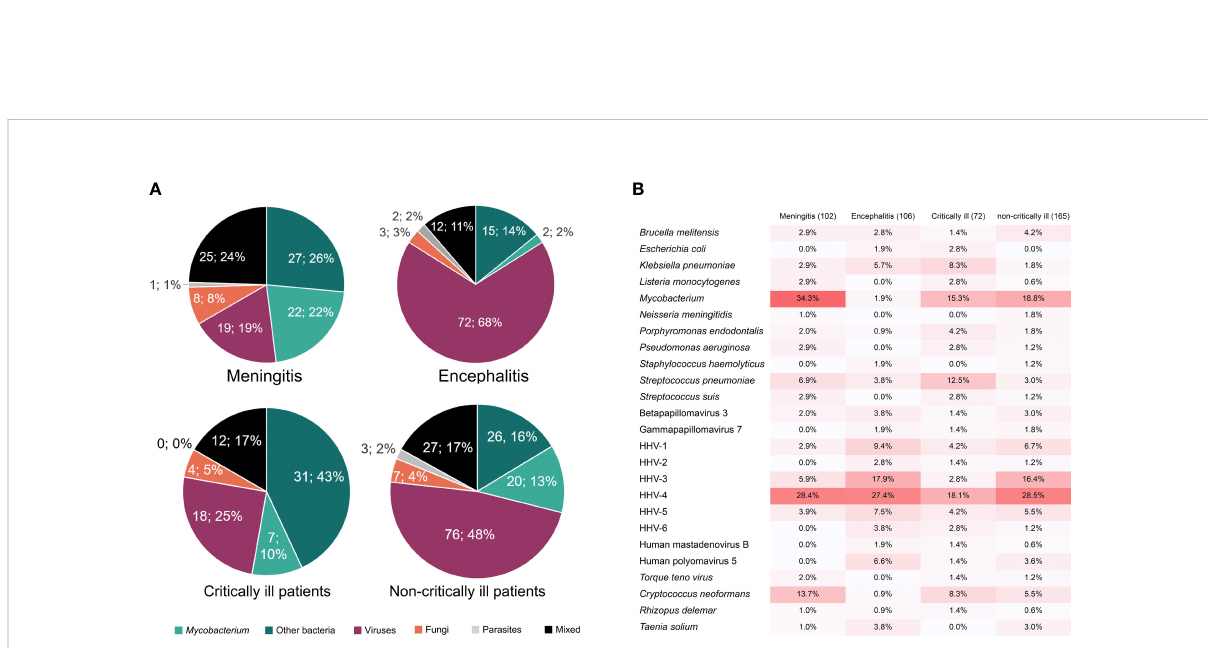
FIGURE 4 The percentages of causative pathogens in meningitis, encephalitis, critically ill, and non-critically ill patients by mNGS using cfDNA. (A) , Different kinds of infections in meningitis, encephalitis, critically ill, and non-critically ill patients. (B) , Main causative pathogens in meningitis, encephalitis, critically ill, and non-critically ill